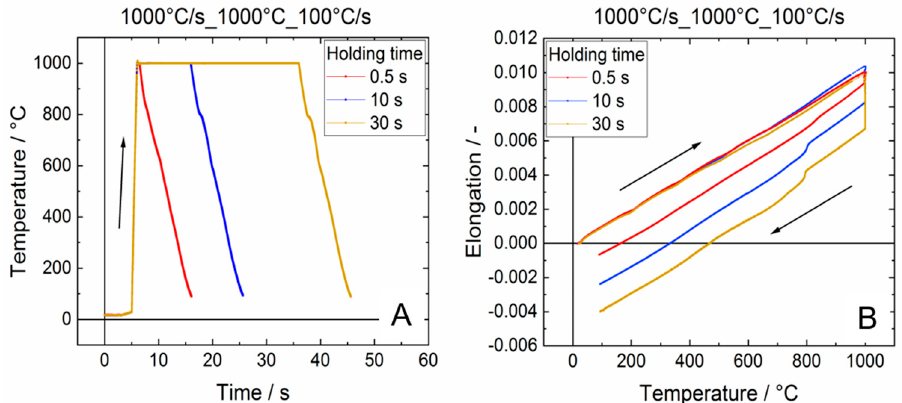
Figure 3. Typical dilatometer results for the alloy Ti6Al4V ELI. Temperature-time-curves ( A ) and corresponding elongation-temperature-distributions ( B ) at the maximum temperature of 1000 °C for the three different holding times 0.5, 10 and 30 s.